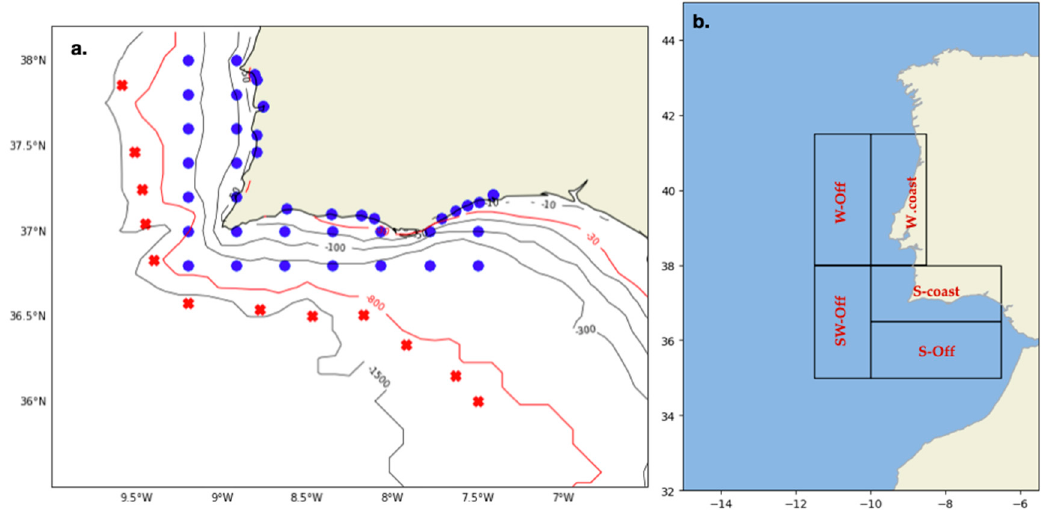
Figure 2. ( a ) Microplastic inputs around the SW Iberian coast for each designated depth: surface and 30 m depth as blue circles and 800 m depth as red crosses. Bathymetry is displayed as black isolines from 0 to 1500 m, and red isolines for 30 and 800 m. ( b ) Marine waters of the Iberian Peninsula were grouped into five monitoring boxes: southern Iberian coastal waters (S-coast); western Iberian coastal waters (W-coast); western Iberian offshore waters (W-Off.); SW Iberian offshore waters (SW-Off.); and southern Iberian offshore waters (S-Off.). Table 1. Configuration of point discharges of particles at each depth layer in the ocean model.